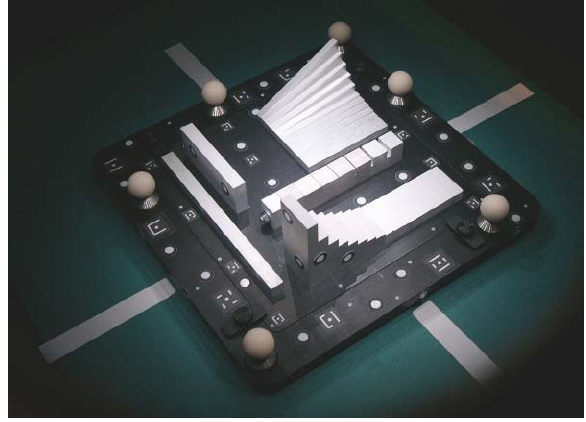
Figure 1. 3D metric test